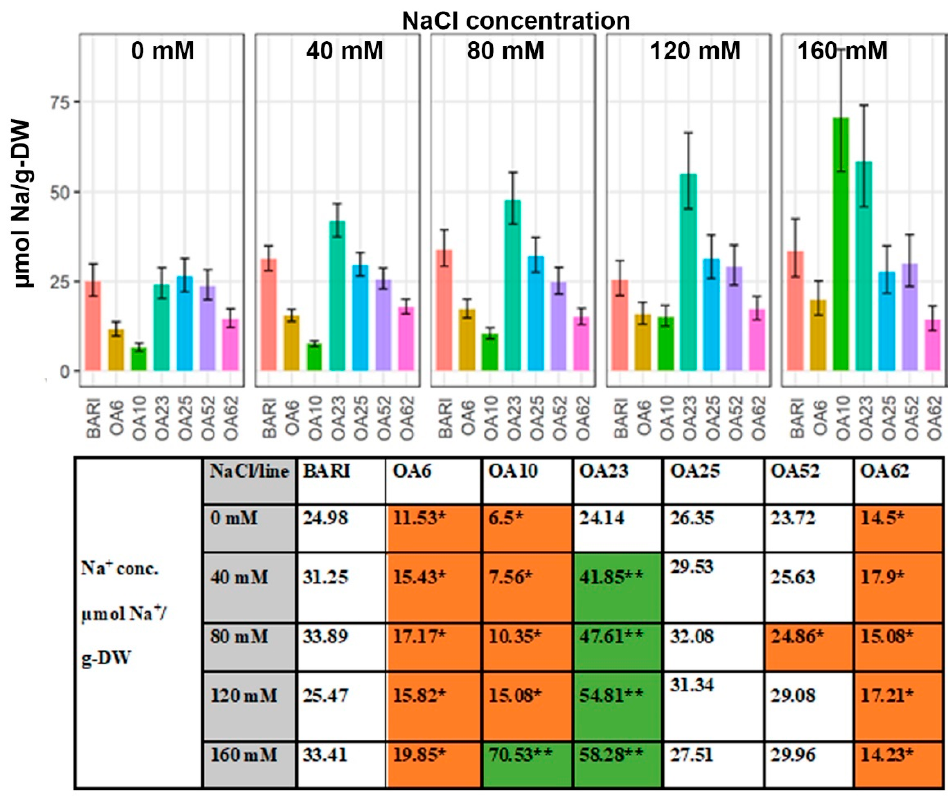
Figure 3. Dry weight (DW) concentration of Na + at DAP 39–40. Data are shown for the control BARI Gom-25 (BARI) and mutagenized wheat lines OA6, OA10, OA23, OA25, OA52, and OA62 at DAP 39–40. NaCl concentrations applied were in the range from 0 mM to 160 mM. Upper panel: Na + values with half-LSD error. Lower panel: table high-lighting the Na + mean values with color codes for significantly higher (dark green **) or lower (orange *) values compared to BARI Gom-25, p ≤ 0.05.